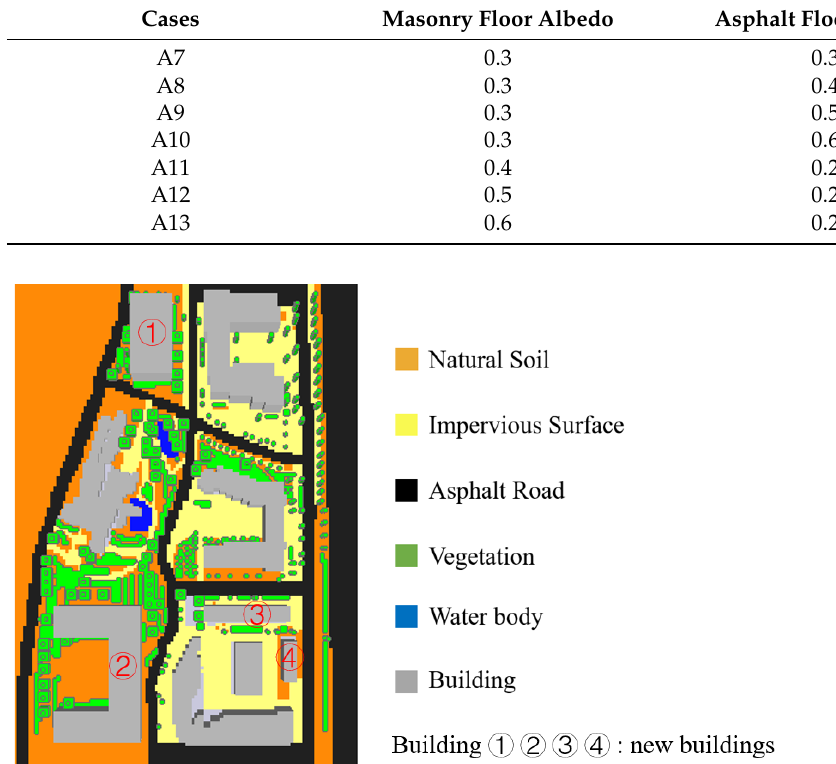
Figure 5. Top view of optimized model of building layout. Table 4. Cases for vegetation greening.